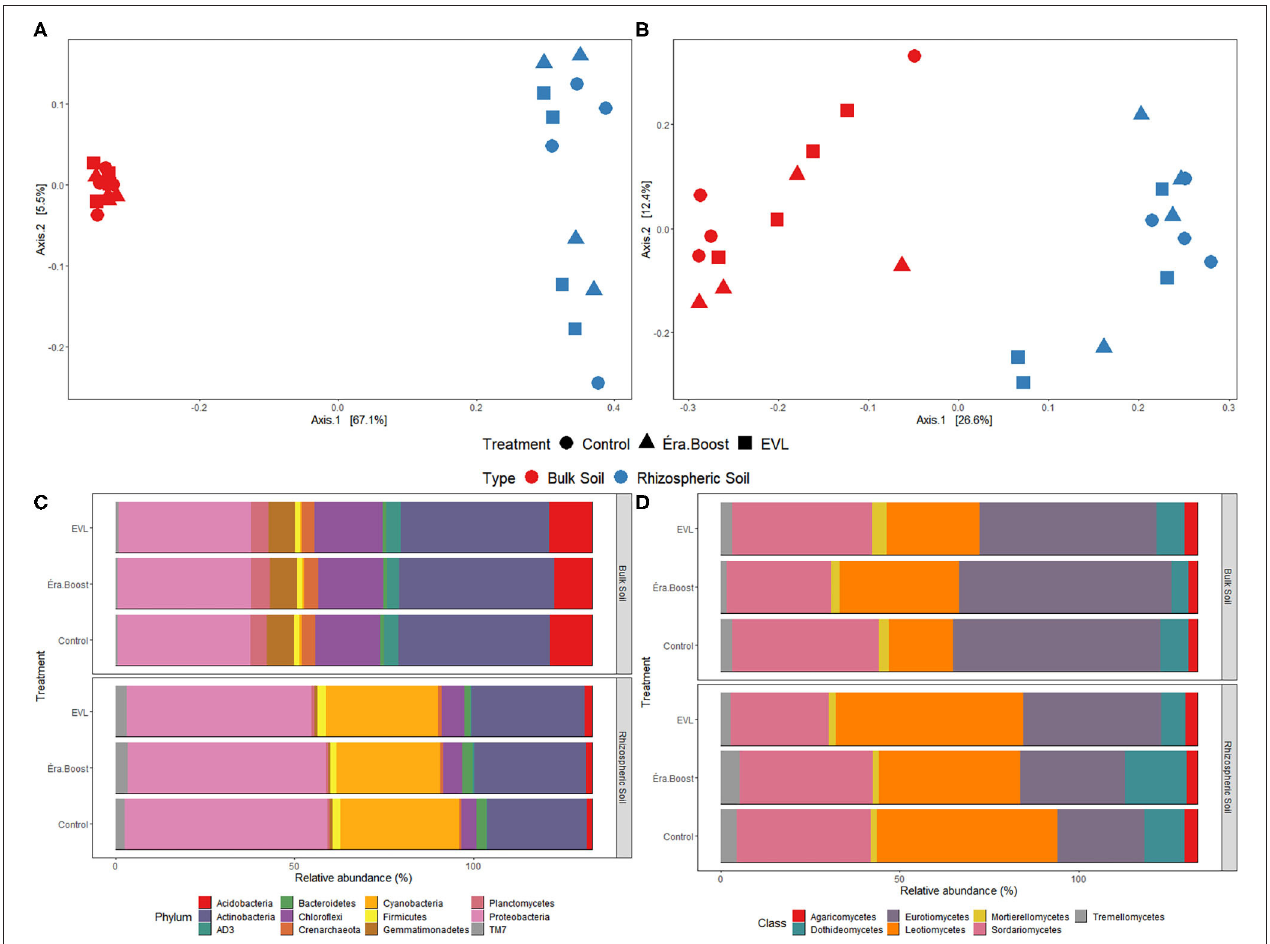
FIGURE 5 | Principal coordinates analysis (PCoA) of prokaryotic (A) and fungal (B) communities in bulk and rhizospheric soil sampled on July 26th. PCoAs were based on Bray-Curtis distance at the ASV level; Relative abundance of prokaryotic phyla (C) and fungal classes (D) in bulk and rhizospheric soil samples.